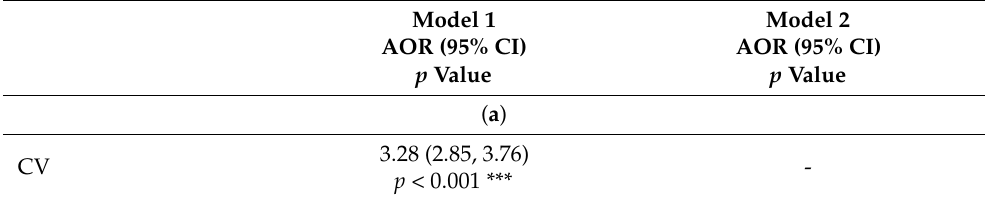
Table 3. ( a ) Logistic multiple regression results to assess the effect of the CV–SV interaction on suicidality among a representative sample of U.S. high school students ( n = 10,309). ( b ) Logistic multiple regression results to assess the effect of the CV–SV interaction on suicidality among a representative sample of U.S. high school students, female subsample ( n = 5333). ( c ) Logistic multiple regression results to assess the effect of the CV–SV interaction on suicidality among a representative sample of U.S. high school students, male subsample ( n =